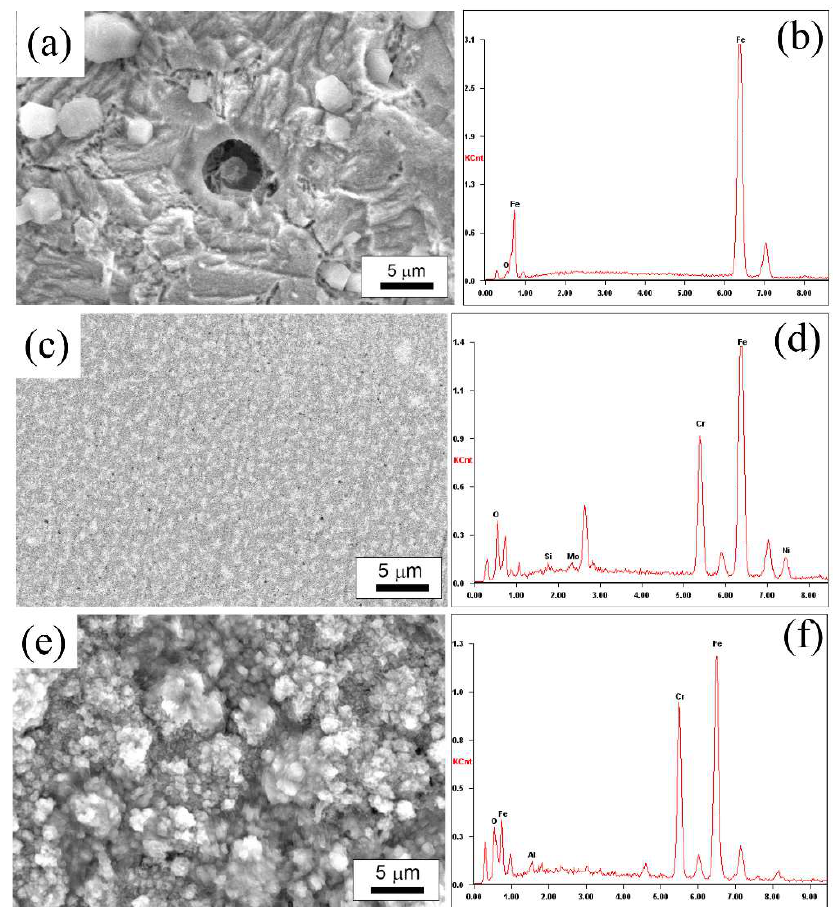
Figure 13. Corrosion morphology and EDS patterns of Q235 carbon steel ( a , b ), 304 stainless steel ( c , d ), and Fe-Al-Cr coating ( e , f ) after electrochemical corrosion in a 0.5 mol/L H 2 SO 4 solution.